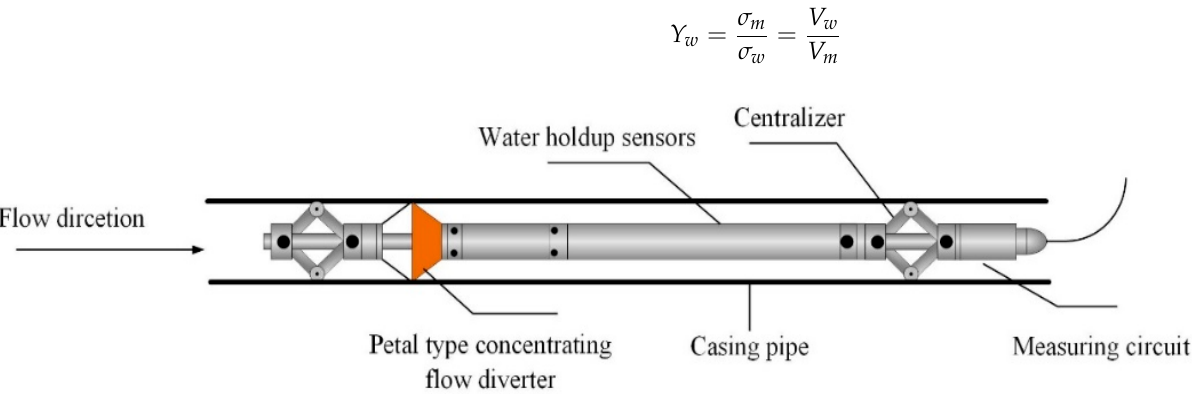
Figure 2. Schematic diagram of water holdup test prototype of horizontal well.